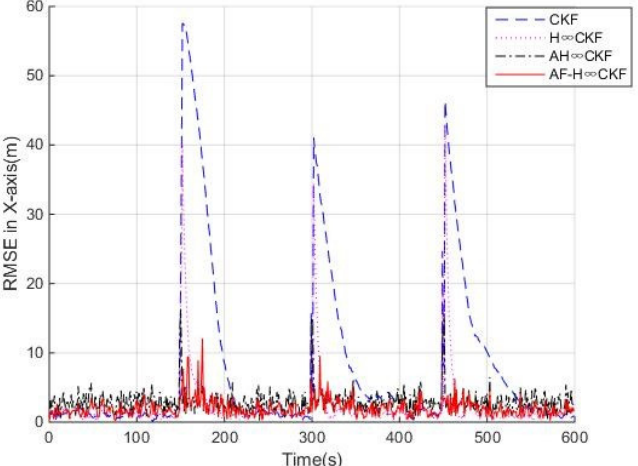
Figure 2. RMSE in the X-axis in Case 1.